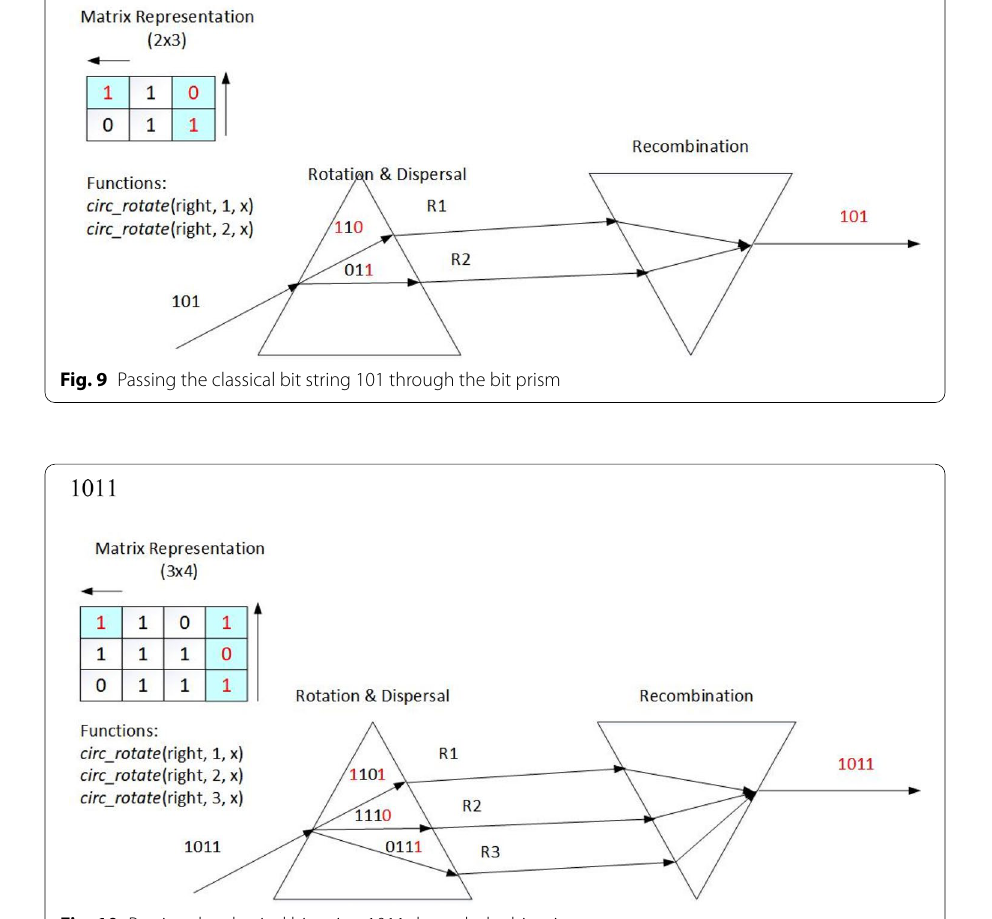
Right (or clockwise) rotation